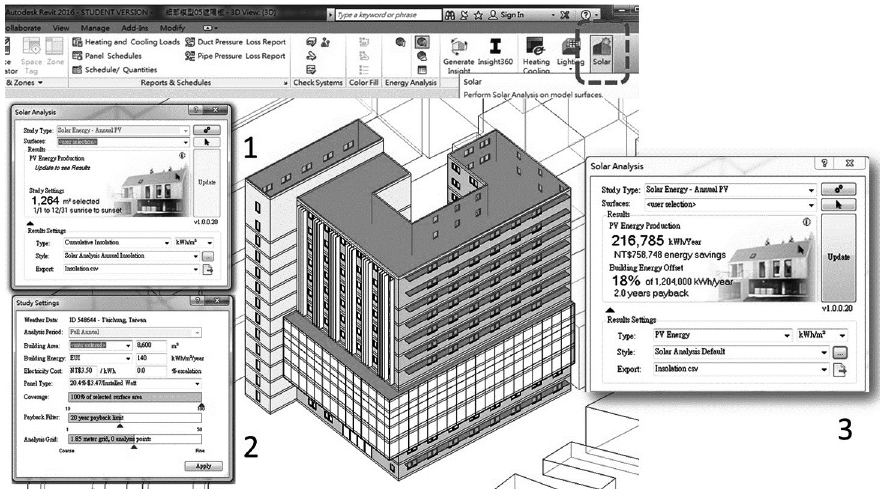
Figure 19. Results of Solar Analysis command